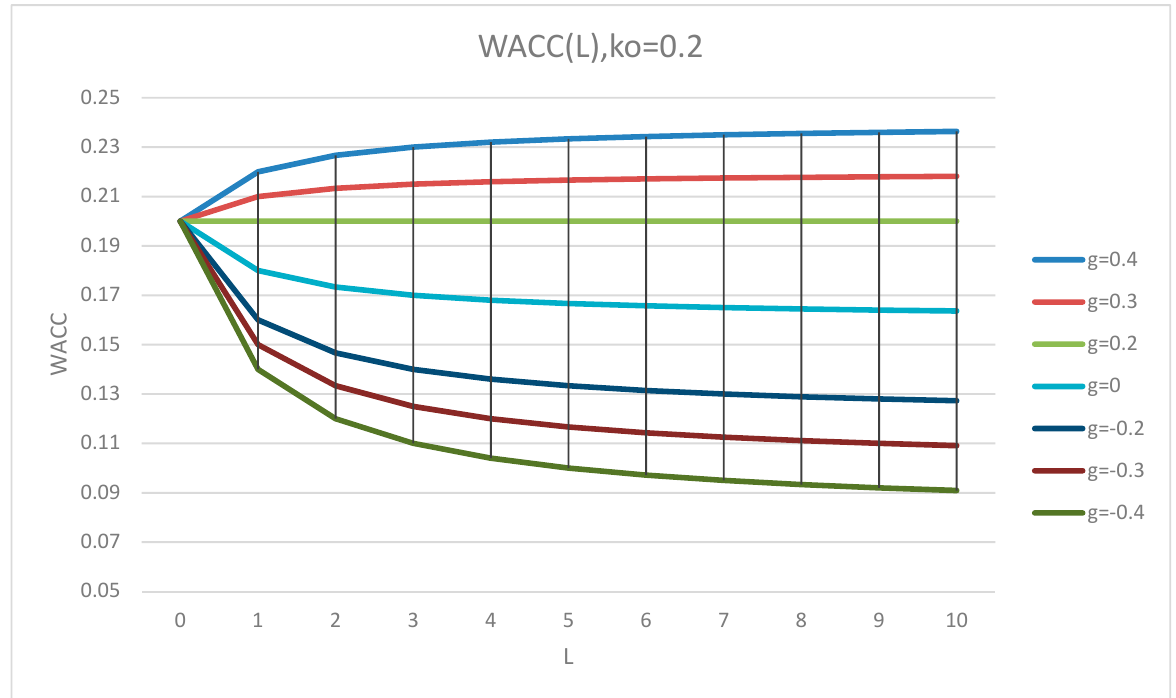
Figure 2. Dependence of WACC on leverage level L in Generalized Modigliani–Miller theory (GMM theory) at k 0 = 0.2 and g = 0; ±0.2; ±0.3; ±0.4.